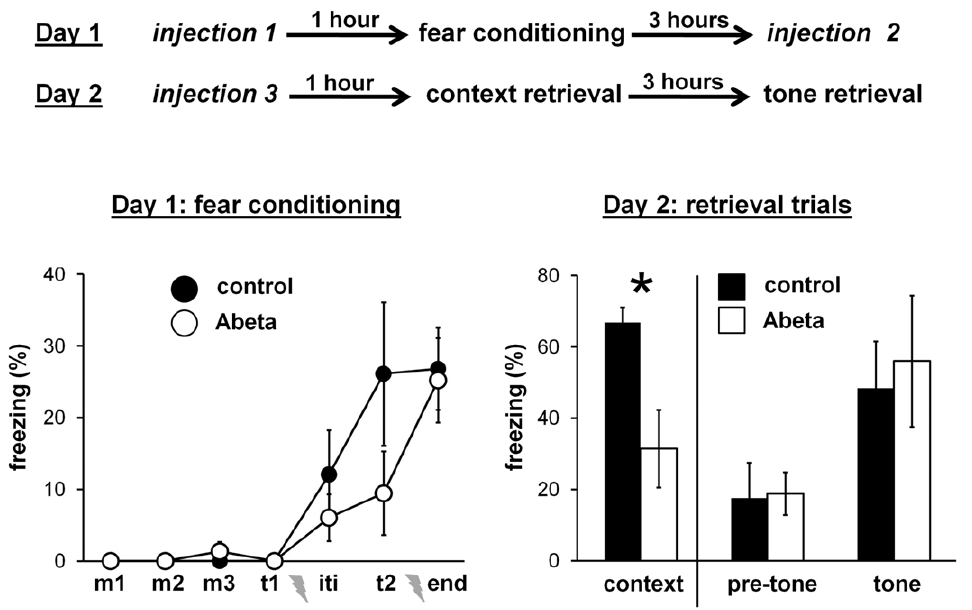
Figure 2. Experiment 1: repeated Abeta injection. Top) Diagram showing the design of experiment 1. Separate groups of mice were injected three times with either control or Abeta solution. Bottom) Graphs showing average freezing scores during fear conditioning on day 1 and the two retrieval trials on day 2 (see ‘‘Materials and Methods: Analysis of freezing behavior’’ for explanation of intervals on the X axis). Mice injected with the Abeta solution (n=5) had significantly lower freezing scores during the context fear retrieval trial as compared with mice injected with the control solution (n=6). Error bars are standard errors of means. * P , 0.05.